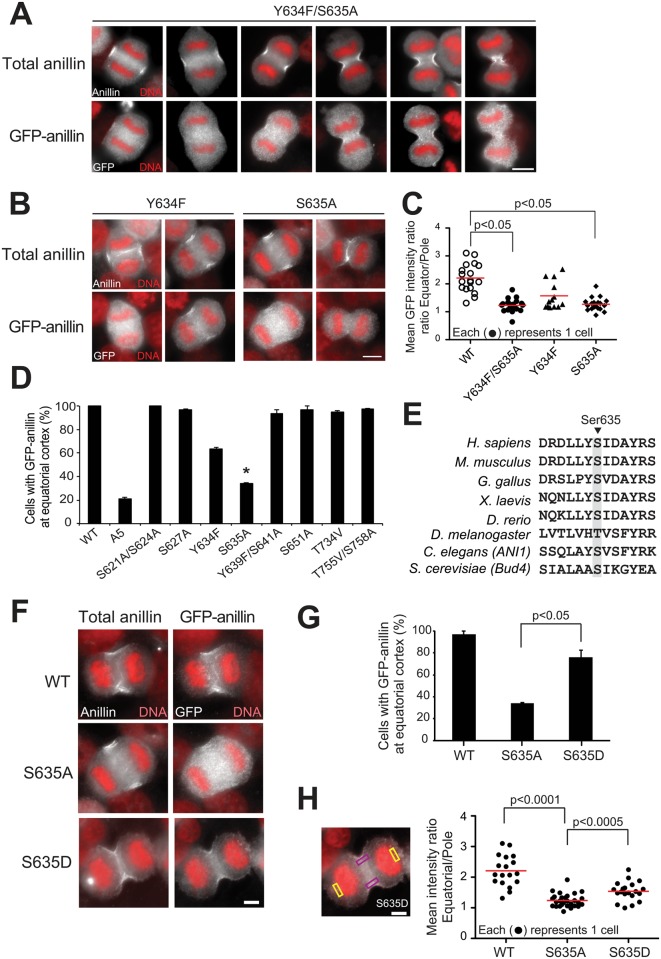
Identification of Ser635 as a critical site for the equatorial localization of anillin at furrow.(A) IF analysis of transiently expressed GFP-anillin Y634F/S635A double mutant. GFP anillin mutants and endogenous anillin were detected using anti-GFP and anillin antibodies, respectively. (B) Localization of Y634F and S634 mutant anillin by IF. (C) Mean intensity ratio of GFP fluorescence at the equatorial cortex:pole for the indicated GFP anillin mutants. Red bars indicate median values. P values by Student’s t-test. (D) Quantification of GFP anillin mutants at equatorial furrow. Summary of 8 single non-phosphorylatable GFP mutants’ localization. Error bars, mean ± s.e. from three experiments. *p<0.05 (E) Sequence alignment of the region surrounding S635, revealing conservation. (F) IF analysis of transiently expressed phosphomimetic anillin, S635D. (G) Quantification of phosphomimetic S635 Anillin furrow localization by observer (H) Quantitative immunofluorescence with representative cell from panel F showing regions quantified in violet (equator) and yellow (pole). Red bars in H indicate median values. P values by Student’s t-test. Scale bars, 5 μm. See also S2 and S3 Figs.